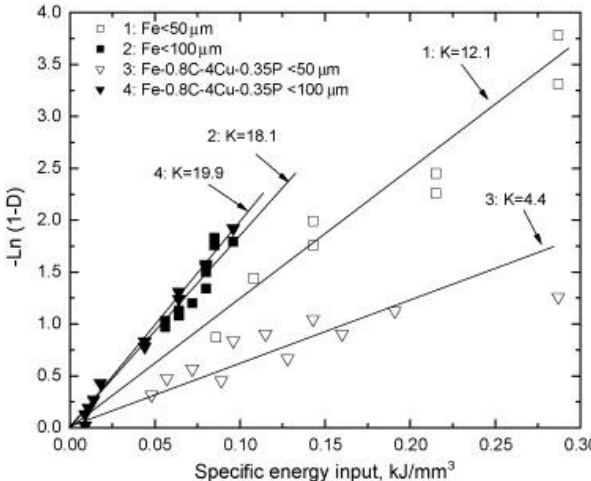
Figure 3. Effect of particle size on the densification of Fe and Fe – 0.8C – 4Cu – 0.35P powders. Higher K value shows lower densification during direct metal laser sintering. Reproduced from [40], with permission from Elsevier, 2006.